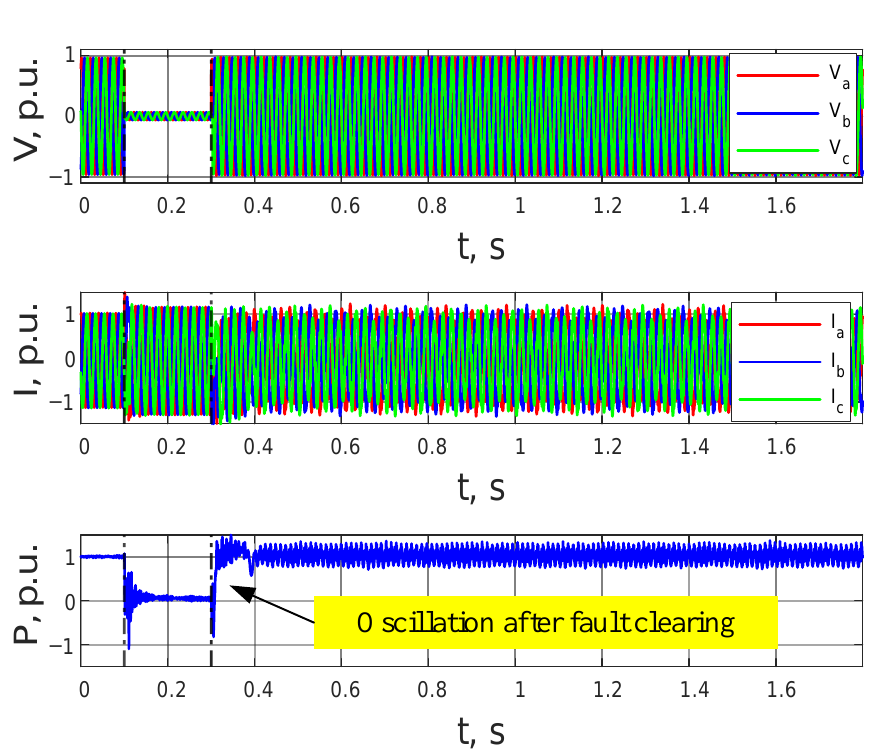
Figure 18. Restart without optimized control method (instable after the fault clearing).